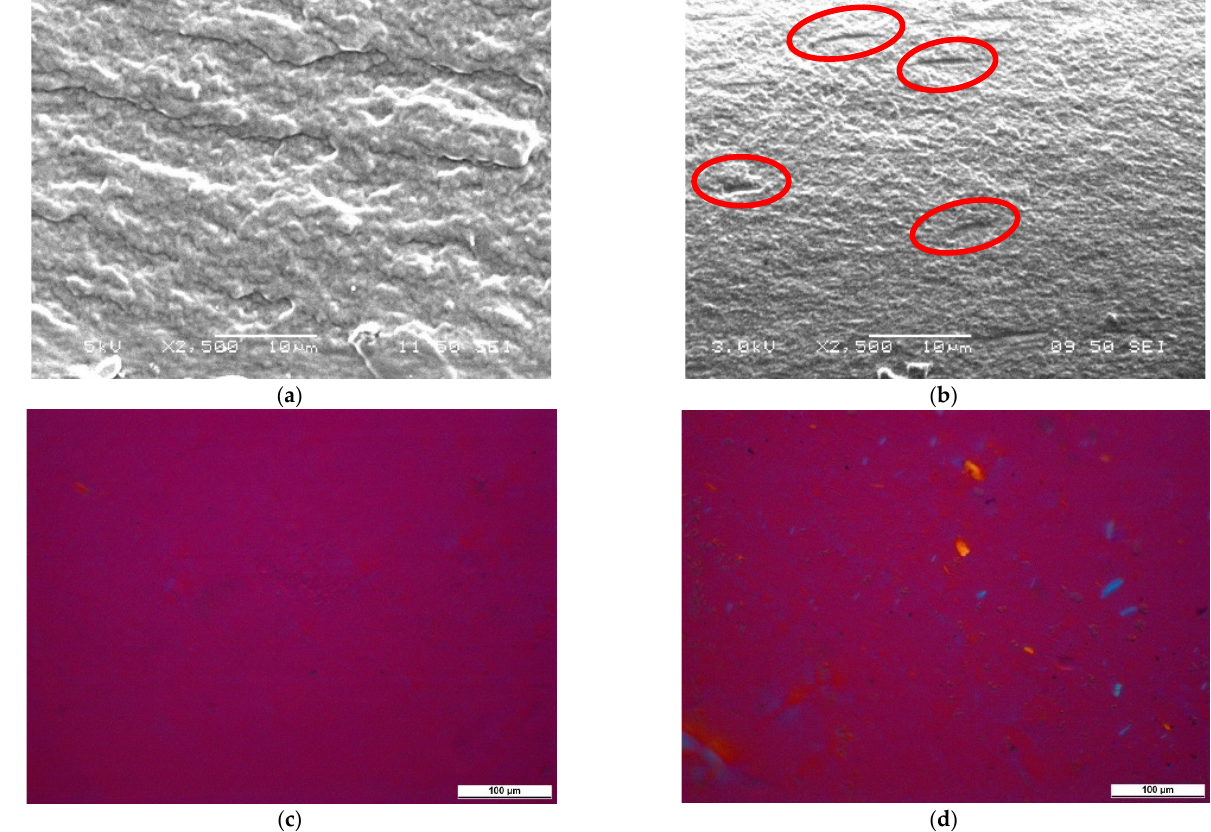
Figure 4. SEM images of cryogenic fracture surfaces and POM images of composite films: ( a ) SEM micrograph of TPS; ( b ) SEM micrograph of TPS with 20% CNCs; ( c ) POM micrograph of TPS; ( d ) POM micrograph of TPS with 20% CNCs. Plasticizer: 40% glycerol.